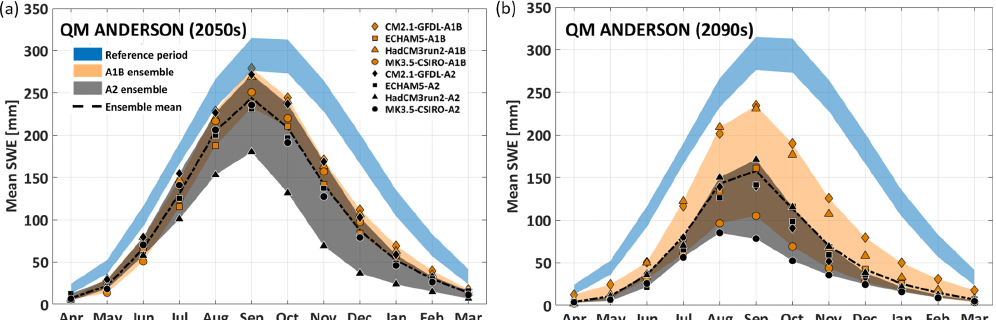
Figure 10. The monthly SWE storage simulated by the QM-Anderson sub-ensemble is depicted for (a) the 2050s and (b) the 2090s period. The individual members are augmented by the A1B envelope, the A2 envelope and the ensemble mean (dashed line). The blue envelope represents the range of SWE volume simulations during the baseline period.